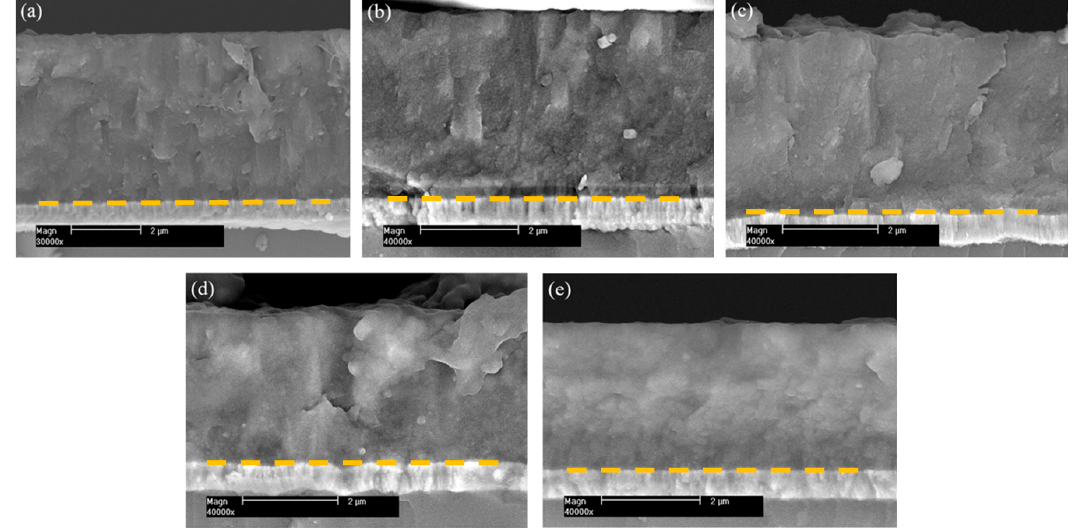
Figure 5. Cross-sectional morphologies of Cr-DLC films deposited at set values of: ( a ) 2%, ( b ) 5%, ( c ) 10%, ( d ) 15%, and ( e ) 20%. The start of the Cr-DLC films was marked by a yellow line in each figure.